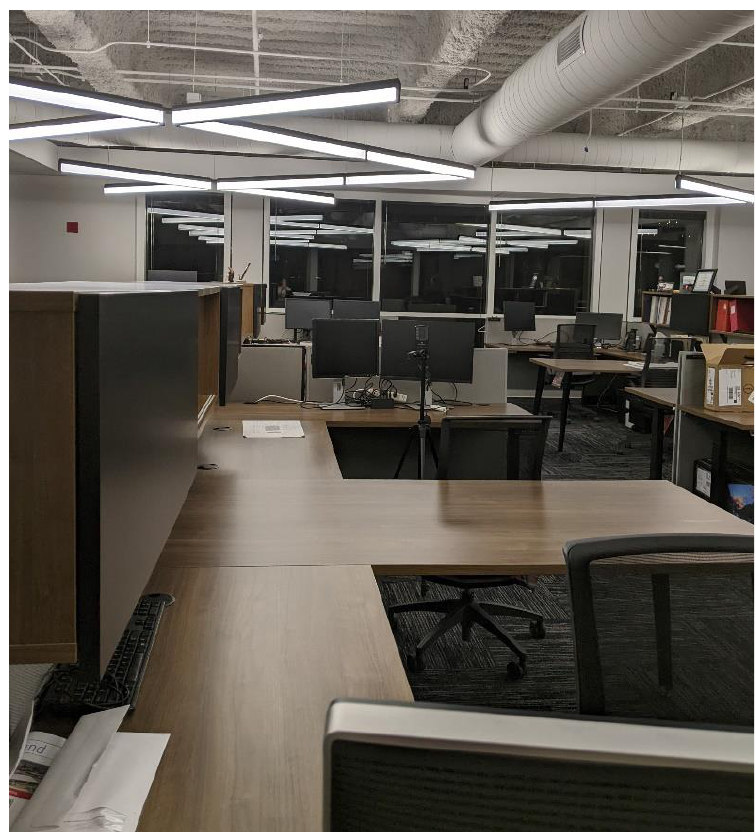
Figure 1. An image of typical workstations in the open office area.